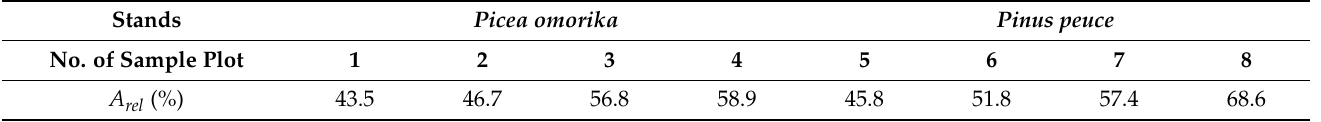
Table 4. Values of the relative species profile index ( A rel ).